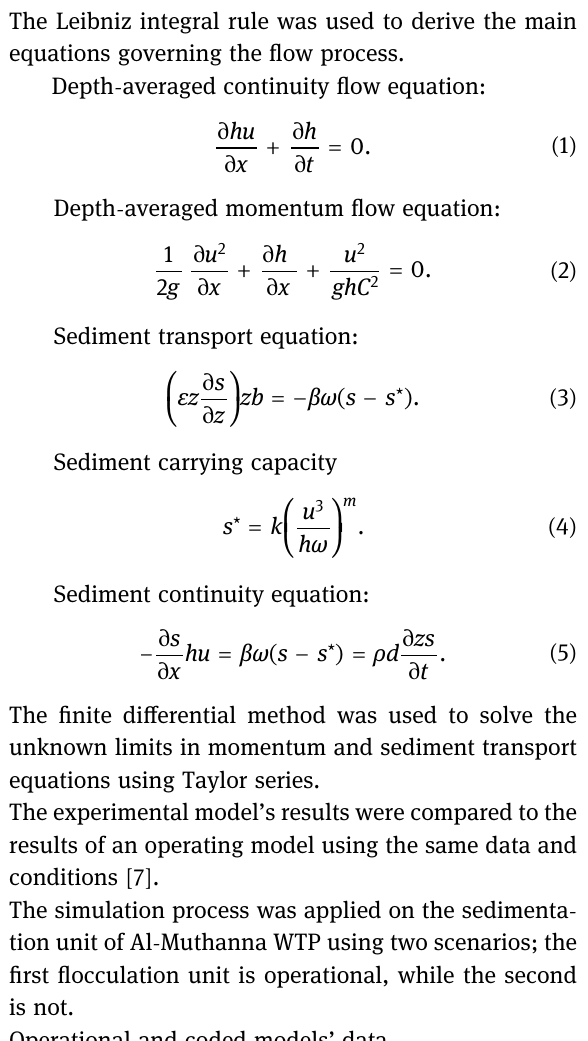
model and de fi nition sketch of operation model that